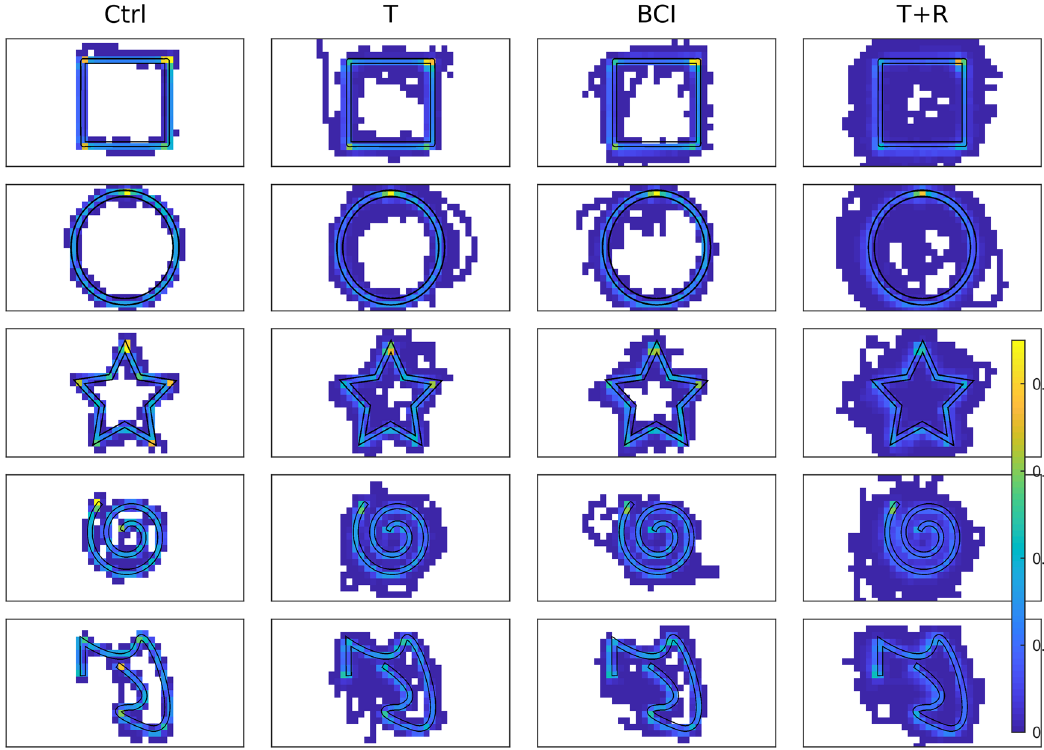
Figure 5. Heatmap-analysis of all shapes and conditions. For each shape (rows) and each condition (columns), all participants’ relative amount of tracking points was averaged and color-coded on a 40 × 20 grid. Cells with a relative amount of exactly 0 tracking points are shown in white, all other values are shown on a scale from blue (low) to yellow (high). Due to a generally higher density of tracking points around the starting area (see text), color values there (and only there) are not to